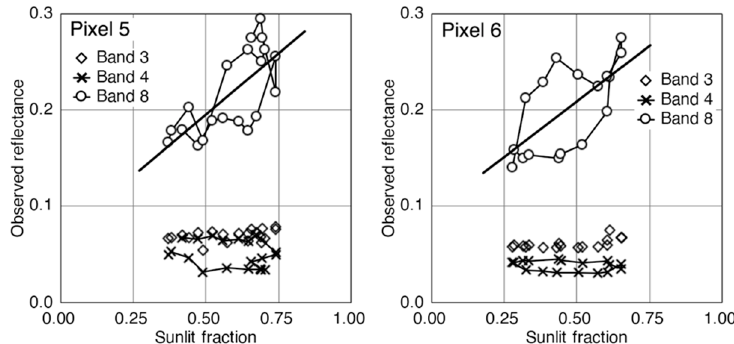
Figure 14. Seasonal relations of sunlit fraction and observed reflectance of the pixels over the logging road ( left ) and deciduous tree area ( right ). Pixel locations are shown in Figure 5b.